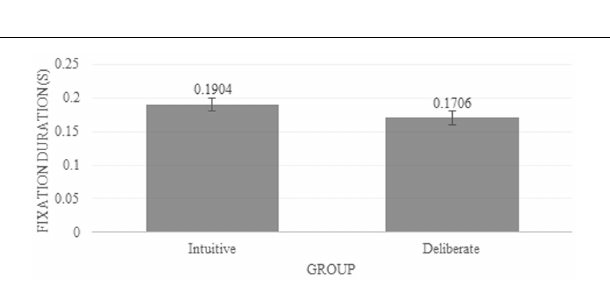
FIGURE 5 | Average duration of fixations on the significant area. Error bars indicate standard